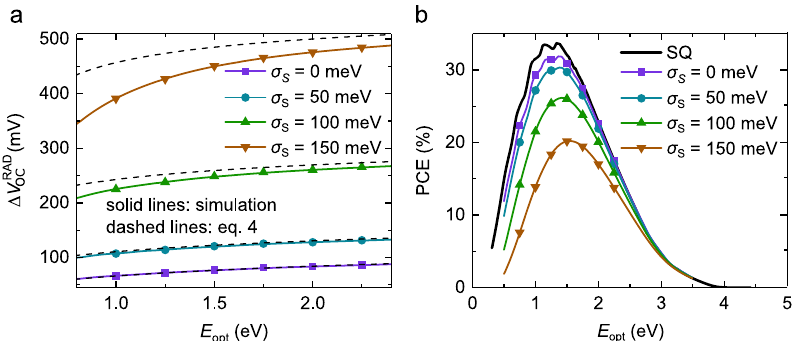
Fig. 5 The radiative V OC loss induced by sub-gap absorption and associated radiative PCE limit of low-offset D:A solar cells. a , The radiative voltage loss Δ V RAD as a function of the optical bandgap for varying degree of Gaussian static disorder σ s , assuming the sub-gap absorption dominated by LEs as OC per Eq. 3 (solid lines with symbols). The corresponding analytical approximation (Eq. 4) is represented by the dashed lines. b , The corresponding radiative PCE limit based on Eq. 3, assuming EQE max ¼ 1 and ideal charge collection, is shown (solid lines with symbols). For comparison, the SQ limit, representing the ideal case with no sub-gap absorption, is included as indicated by the black solid line. The PCE decreases with respect to the SQ limit as σ The SQ limit is not expected to be reached even for vanishing σ s due to the